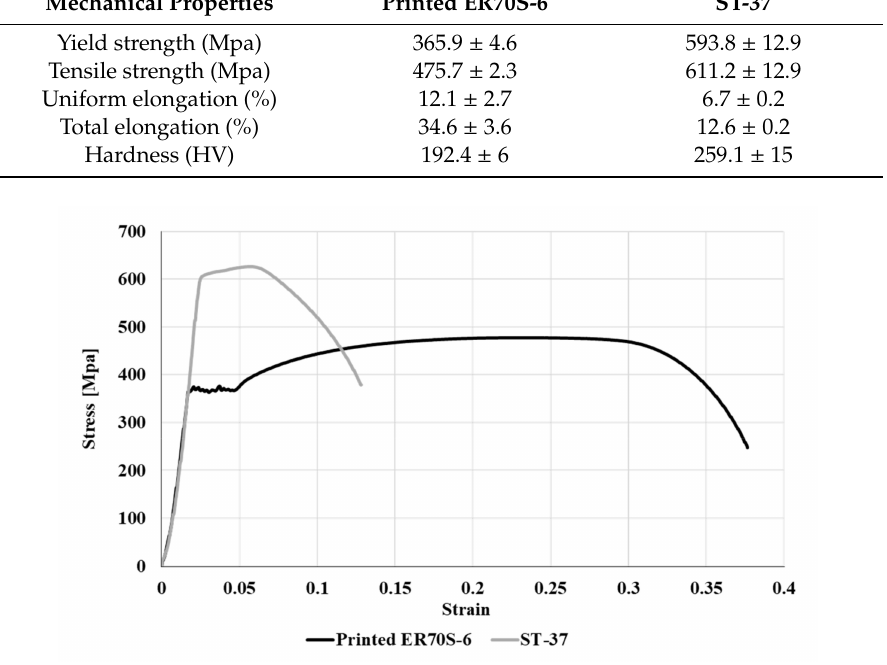
Figure 6. Typical stress–strain